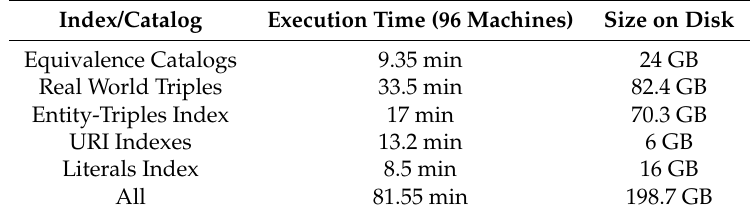
Table 5. Construction time and size of catalogs and indexes.